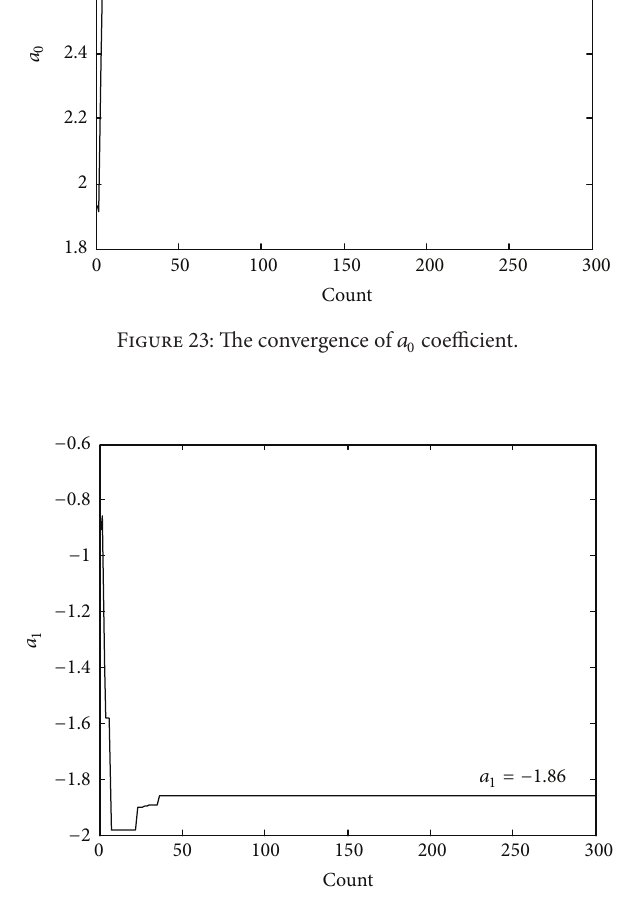
Figure 24: The convergence of 𝑎 1